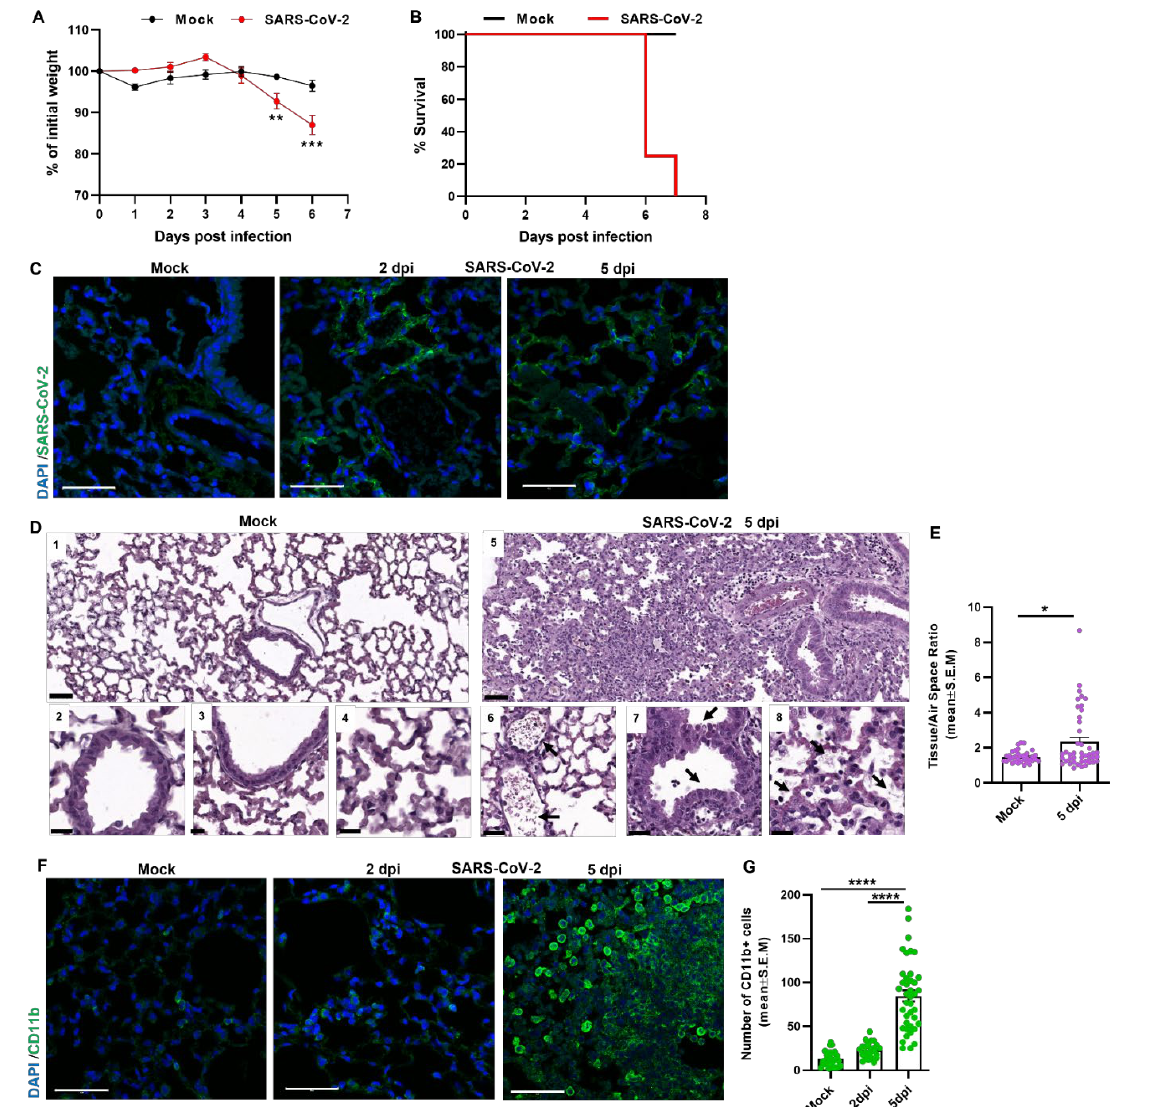
Figure 1. K18-hACE2 mouse model for airways infection with SARS-CoV-2. ( A ) Body weight changes of i.n mice infected with 2000 pfu of SARS-CoV-2 compared to mock (n = 6 for Mock and SARS-CoV-2, the error bars represent the SEM), and ( B ) survival rate as depicted by Kaplan–Meier survival curves (n = 20). Weight differences between groups were analyzed by two ways ANOVA (group x time, with repeated measure on the latter) followed by an appropriate post hoc analysis (Dunnett) using GraphPad 7. ** p < 0.01, *** p < 0.001. ( C ) Representative SARS-CoV-2 immunolabeling of lung sections of mock and SARS-CoV-2-infected mice at 2 and 5 dpi. (Scale bar 50 µm). ( D ) H&E staining of lung sections from K18-hACE2 mice, mock or 5 days post infection (dpi). Upper images show low magnification (scale bar 100 µm) and lower images show high magnification (scale bar 50 µm). ( E ) Tissue/Air space ratio analysis of mock and SARS-CoV-2-infected mice (5 dpi), (n = 7 for Mock and n = 8 for SARS-CoV-2), for each mouse five fields were imaged and analyzed. The error bars represent the SEM. Statistical significance was calculated using one tailed Mann Whitney non-parametric statistics * p < 0.05. ( F ) Representative immunofluorescence images of 5 µm lung sections labeled for immune cells marker-CD11b (green) of mock and SARS-CoV-2-infected mice at 2 and 5 dpi. (Scale bar 50 µm). ( G ) Quantitative analysis of CD11b+ cells in lung sections of mock and SARS-CoV-2-infected mice at 2 and 5 dpi (n = 6 for mock and n = 5 for 2 and n = 8 for 5 dpi), for each mouse five fields were imaged and analyzed. The error bars represent the SEM. Statistical significance was Kruskal–Wallis nonparametric test. **** p < 0.0001.